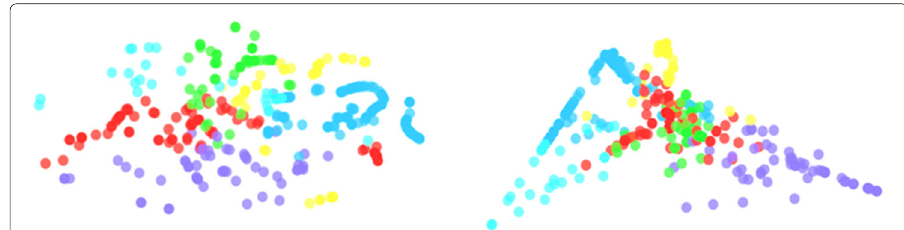
Fig. 4 2D layouts: the layout could be continuously shifted from T-SNE distribution (left) to LDA distribution (right) by a slider. The nodes are colored based on